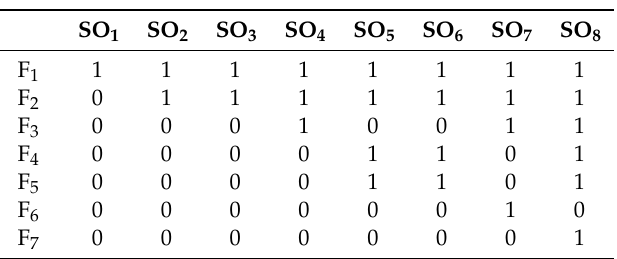
Table 4. Dependency